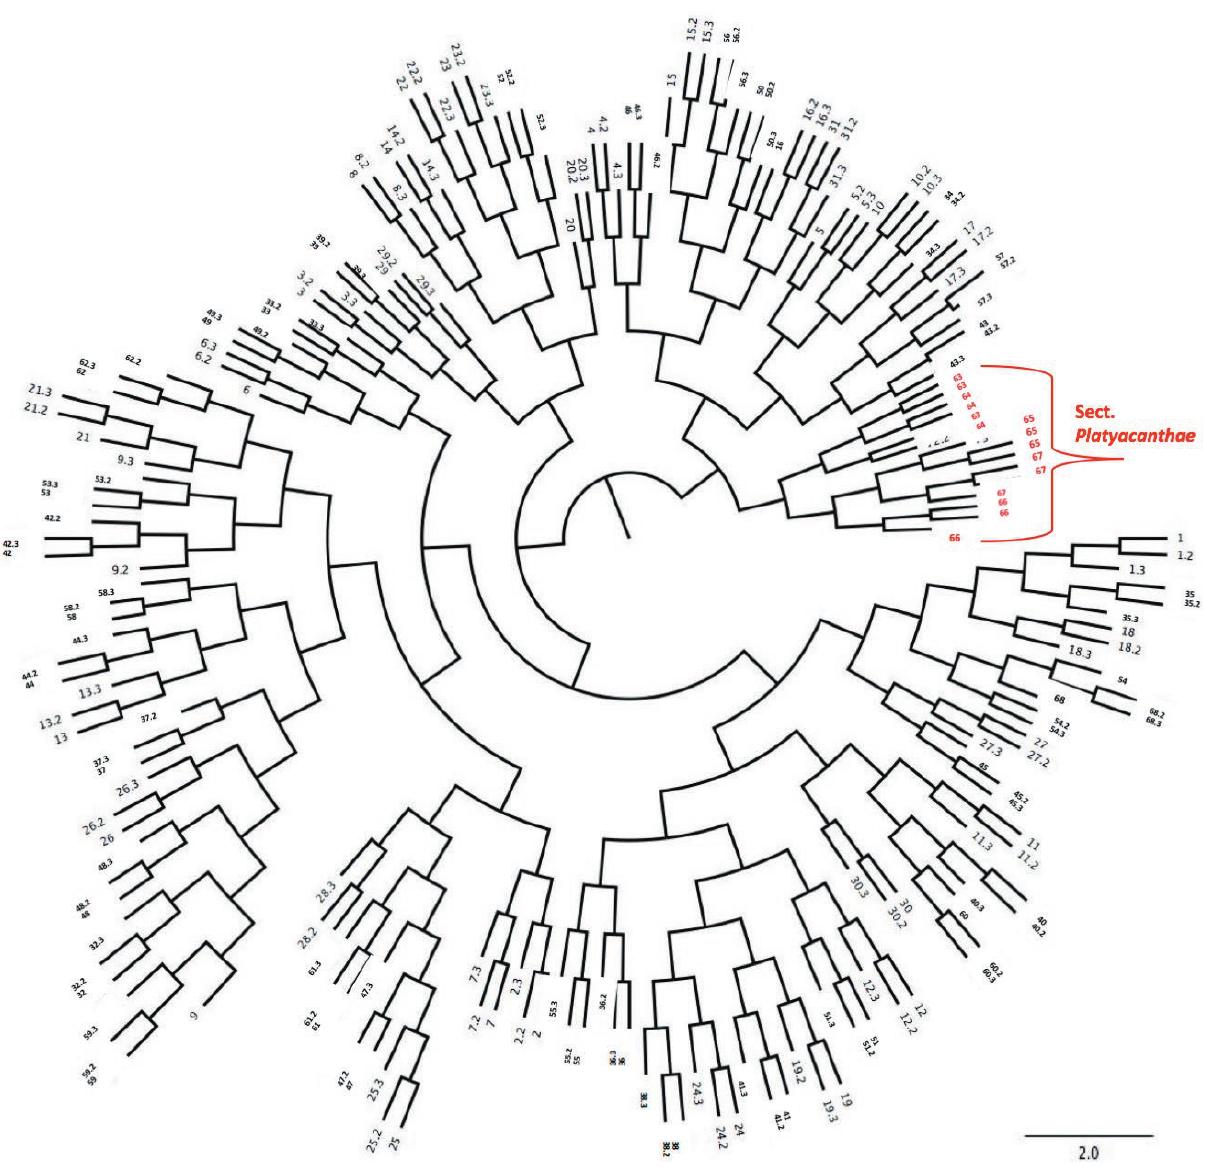
Figure 1. UPGMA dendrogram of the studied Cousinia species based on morphological data. (The specie 1-68 are according to Table